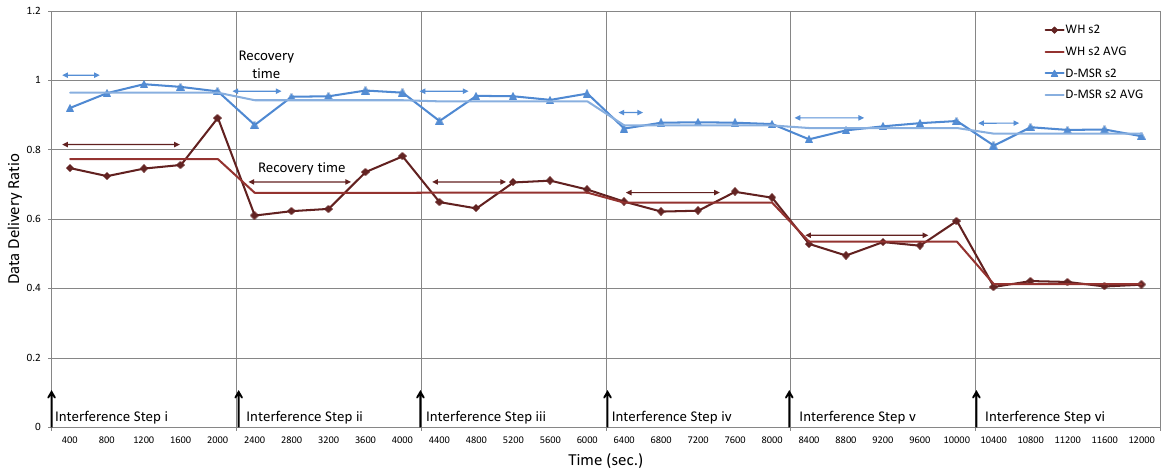
Figure 28. Data delivery ratio difference in two